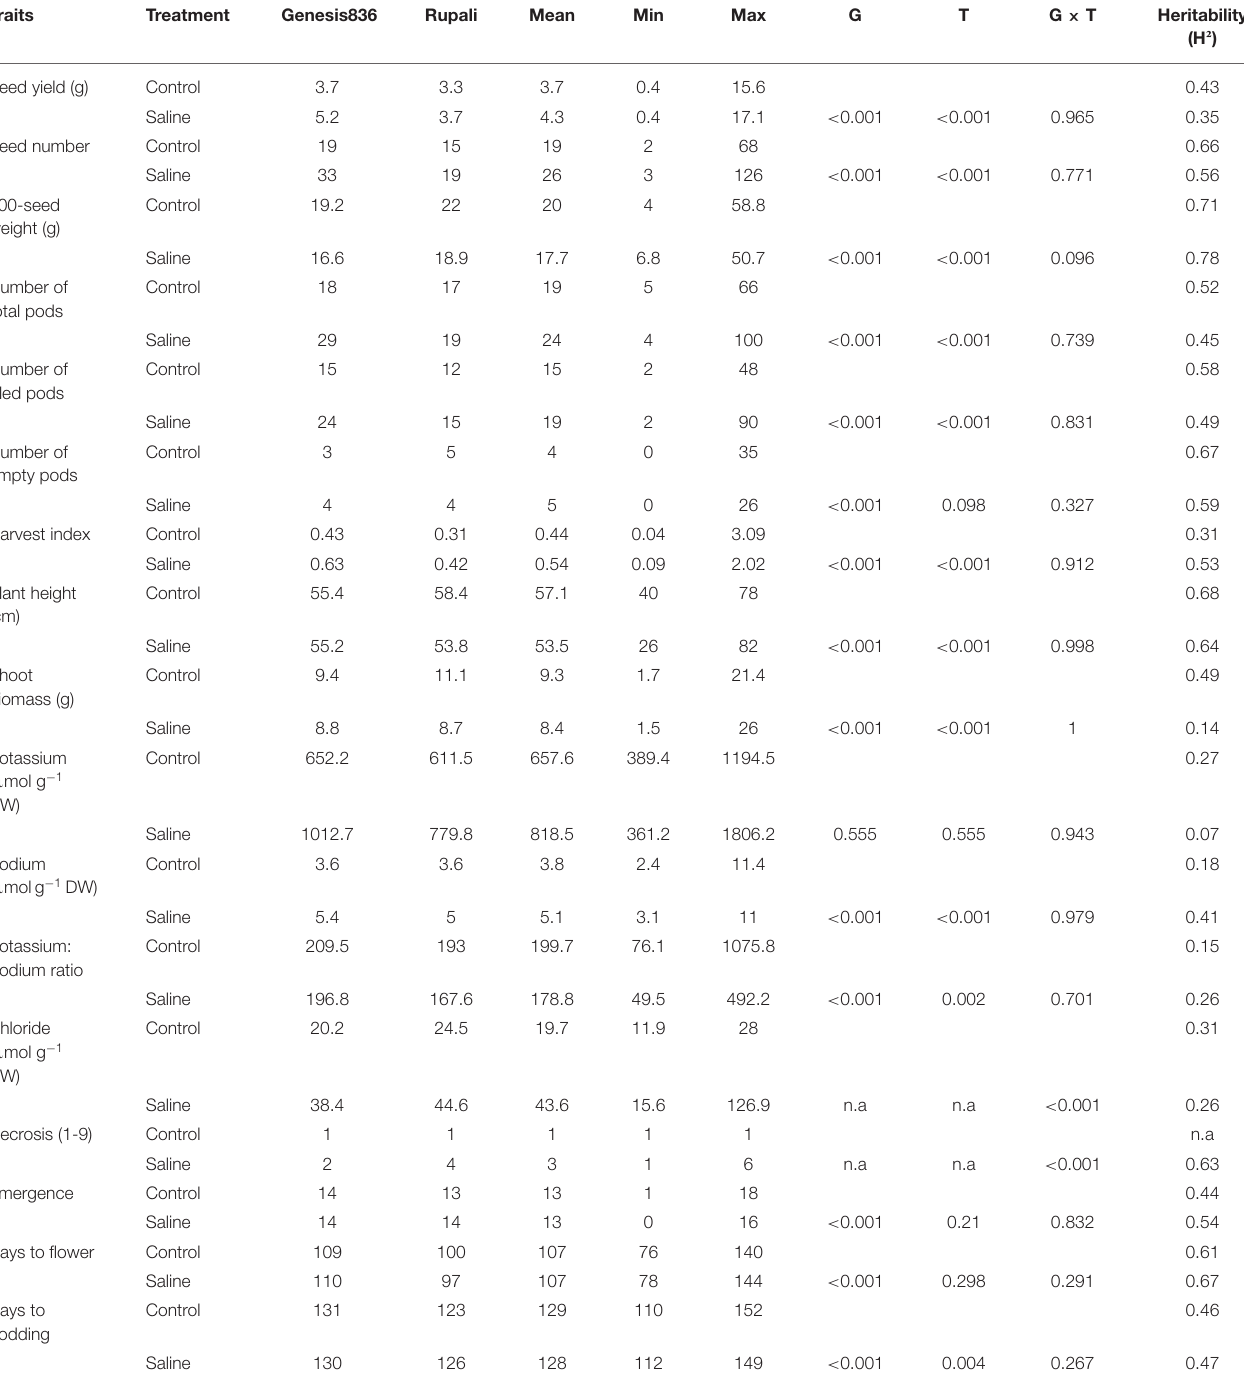
TABLE 2 | Summary of measurements taken in 2017 Merredin field trial (Merredin2017) under salt and control conditions.